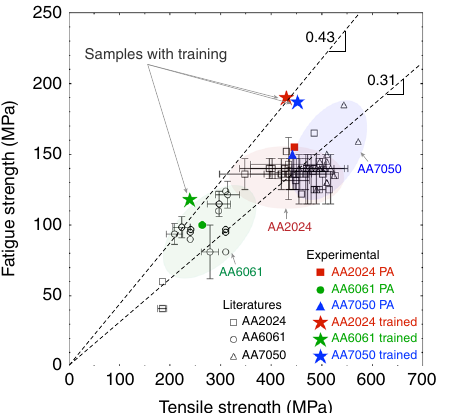
Fig. 1 The fatigue strength vs. ultimate tensile strength (UTS) for commercial AA2024, AA7050, and AA6061 alloys. Correlation between fatigue strength and tensile strength for three Al alloys. 10 – 15 .